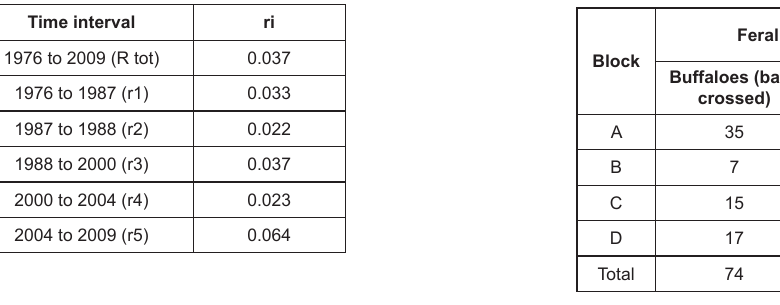
Table 3. Population growth rate of water buffalo over the time period at KTWR